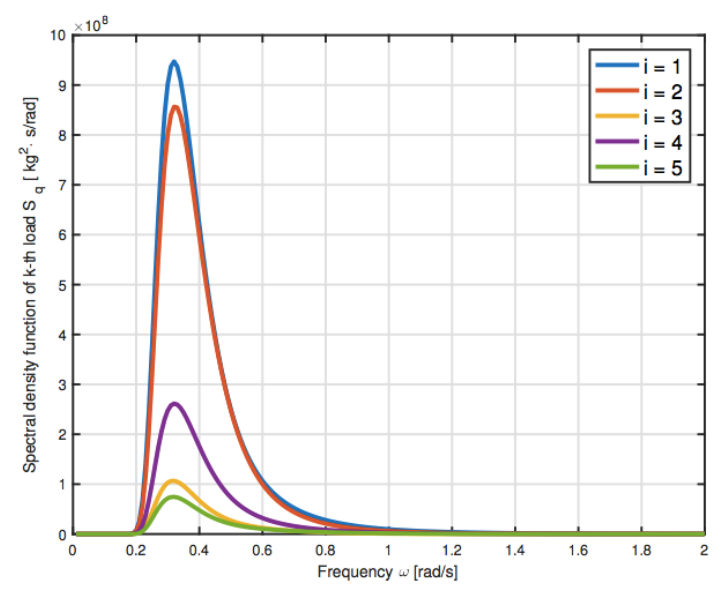
Figure 6. Spectral density functions of the generalized force component in modal coordinates for the 5DOF model.